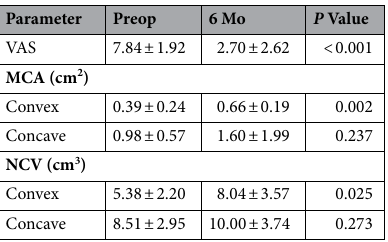
Table 4. Changes in subjective and objective outcomes after revision septoplasty. Data are expressed as means ± standard deviation. MCA = minimal cross sectional area; Mo = month; NCV = nasal cavity